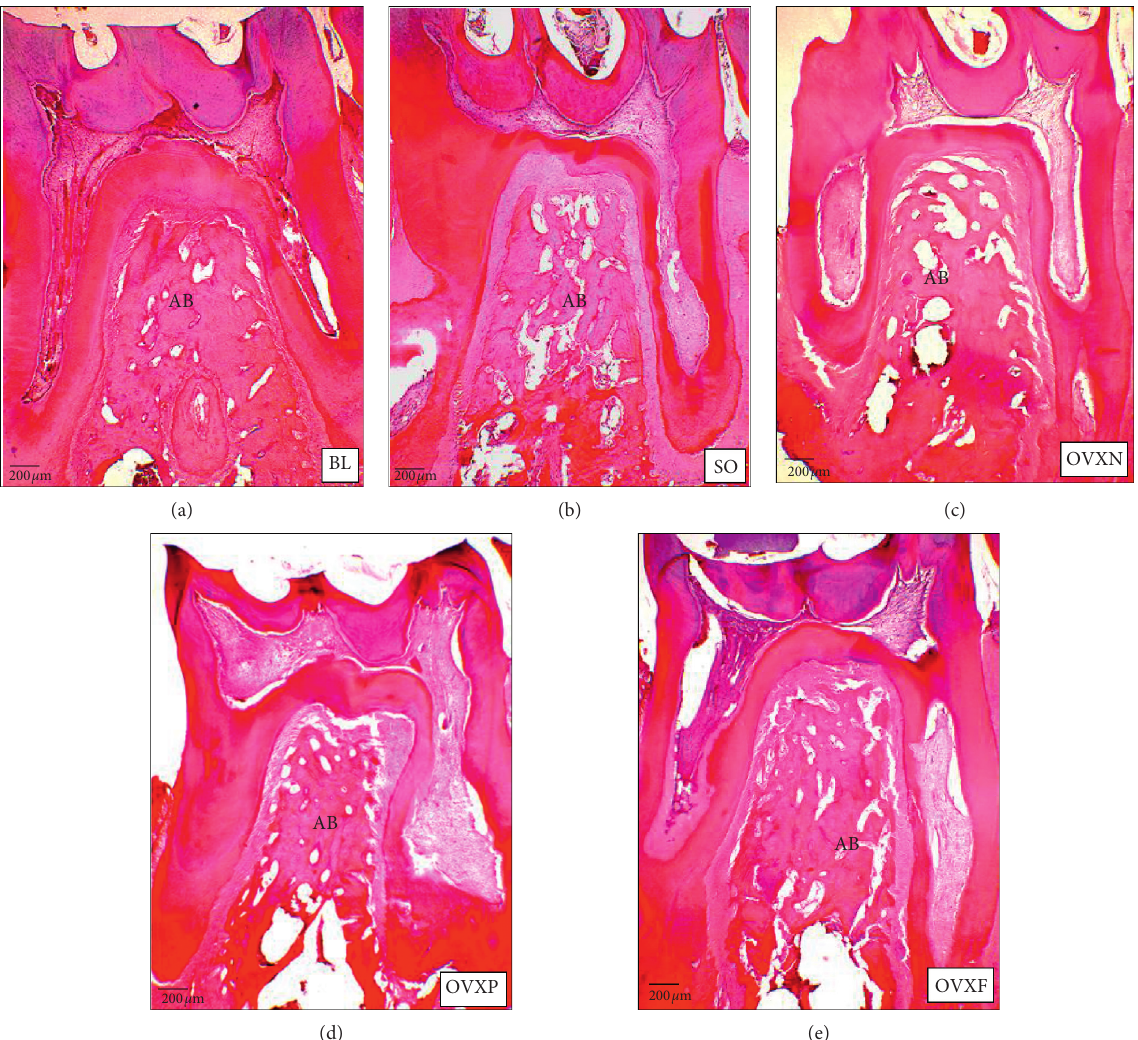
Figure 8: H&E-stained histology images of all groups at the interradicular septum of the first molar after two months of intervention period at 4x magnification. Severe alveolar bone resorption was observed in the OVXN group compared with BL and other groups. AB, alveolar bone; BL, baseline SO, sham-operated; OVXN, ovariectomized; OVXP, ovariectomized +estrogen; OVXF, ovariectomized + F. deltoidea